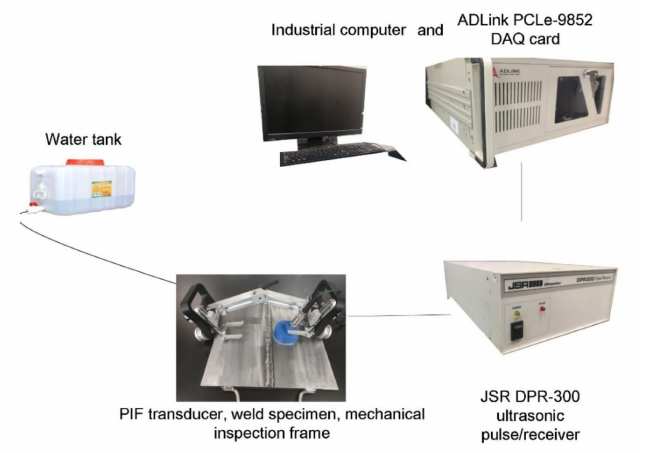
Figure 6. Experimental